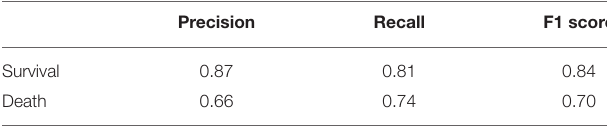
TABLE 2 | Confusion matrix of the XGBoost model. Precision Recall F1